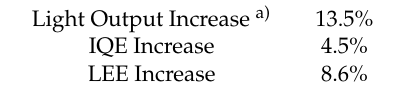
Table 2. Calculated light extraction efficiency (LEE) based on the light output data (Experimental result).